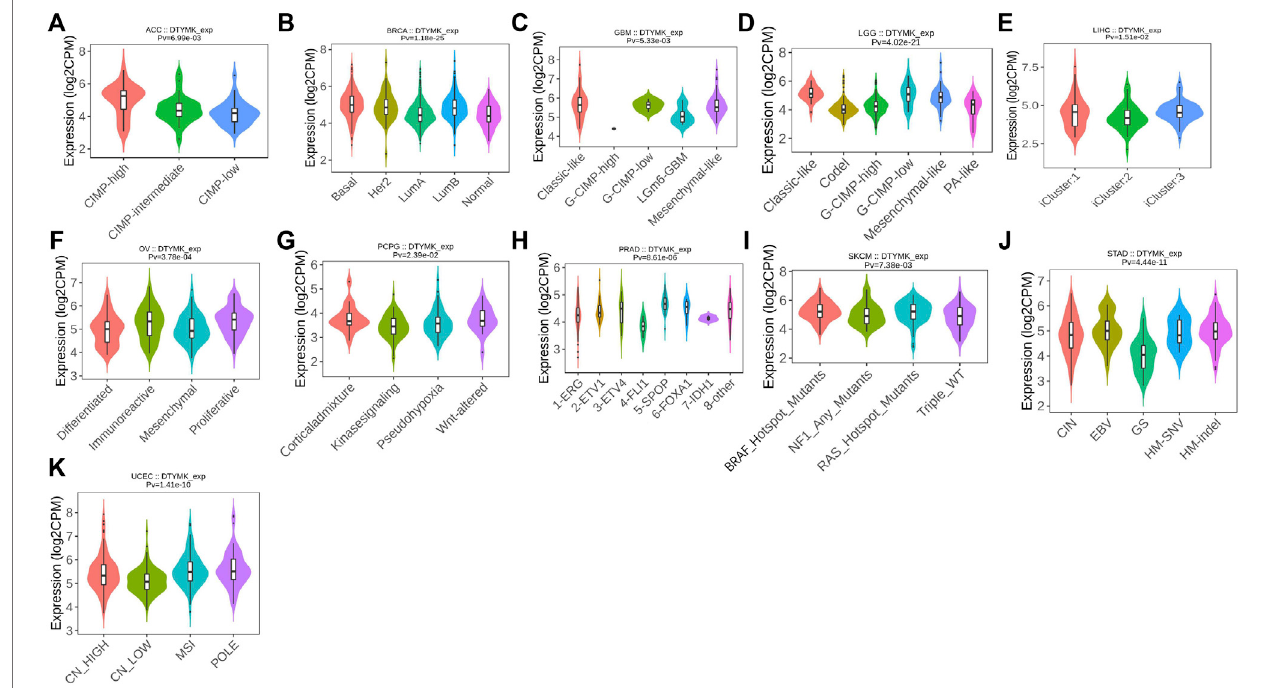
FIGURE 4 | DTYMK expression isdiscriminately distributed indifferent molecularsubtypesofcancers.VariationofDTYMK expression was shown inACC (A) , BRCA (B) ,GBM (C) ,LGG (D) ,LIHC (E) ,OV (F) ,PCPG (G) ,PRAD (H) ,SKCM (I) ,STAD (J) andUCEC (K) .ACC,Adrenocorticalcarcinoma;BRCA,Breastinvasivecarcinoma;GBM, Glioblastomamultiforme;LIHC,Liver hepatocellularcarcinoma;OV,Ovarianserouscystadenocarcinoma;PCPG, pheochromocytomaand paraganglioma; PRAD, Prostate adenocarcinoma; SKCM, Skin cutaneous melanoma; STAD, Stomach adenocarcinoma; UCEC, Uterine corpus endometrial